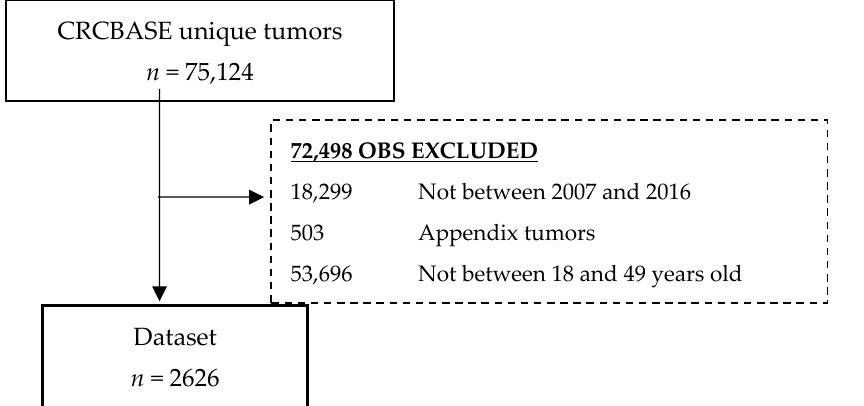
Figure 1. Flowchart of excluded